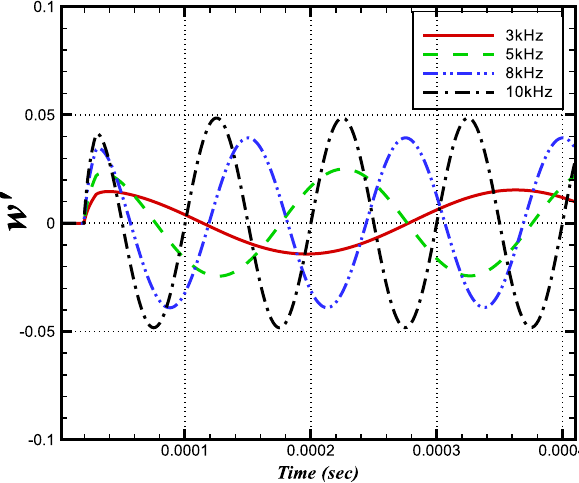
Figure 17. Relative change in the reaction rate of OH at different frequencies and a constant amplitude of 100